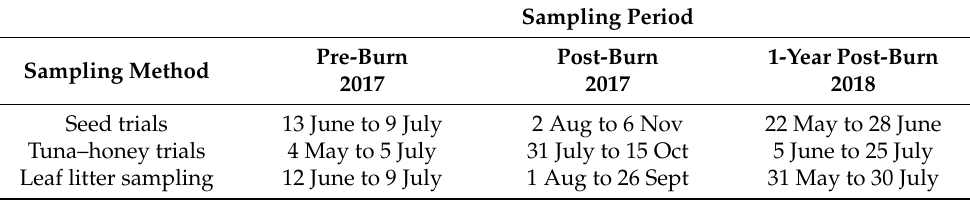
Table 1. Sampling period dates by sampling method. Prescribed burn was conducted on 24 July 2017.